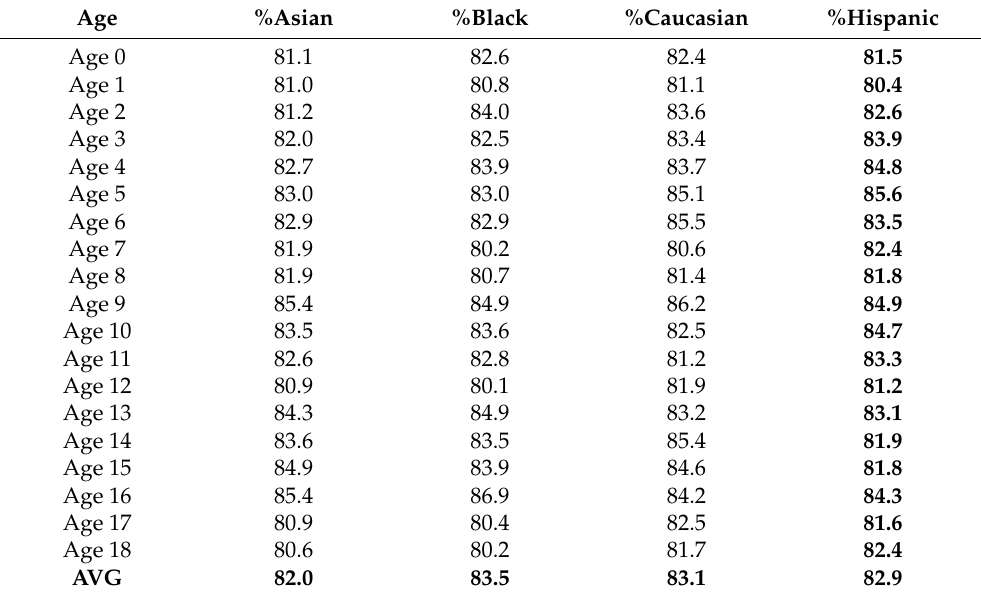
Table 4. Evaluation of the proposed system’s performance for images by Asian, Hispanic, Black, and Caucasian races.